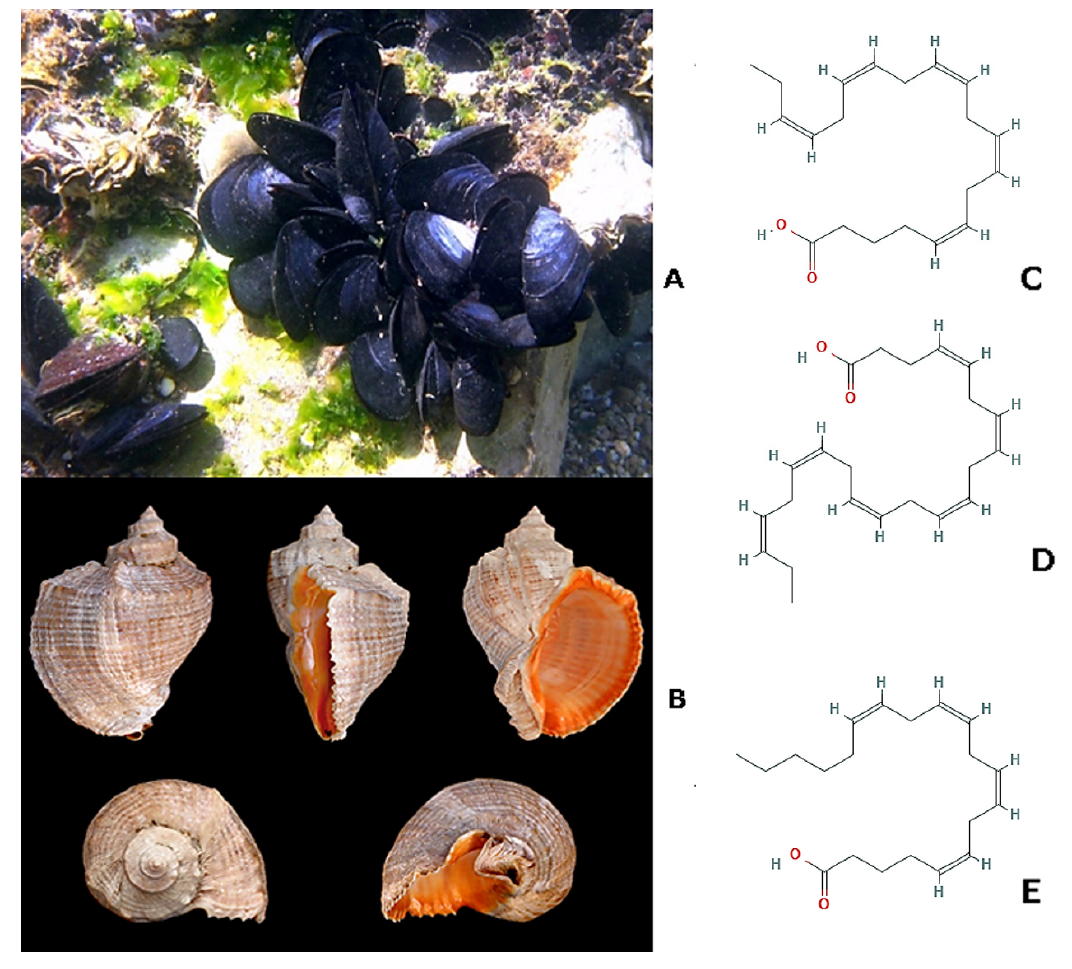
Figure 18. A ) A group of Mytilus galloprovincialis bivalves. © Pillon Robert (CC BY-NC-SA